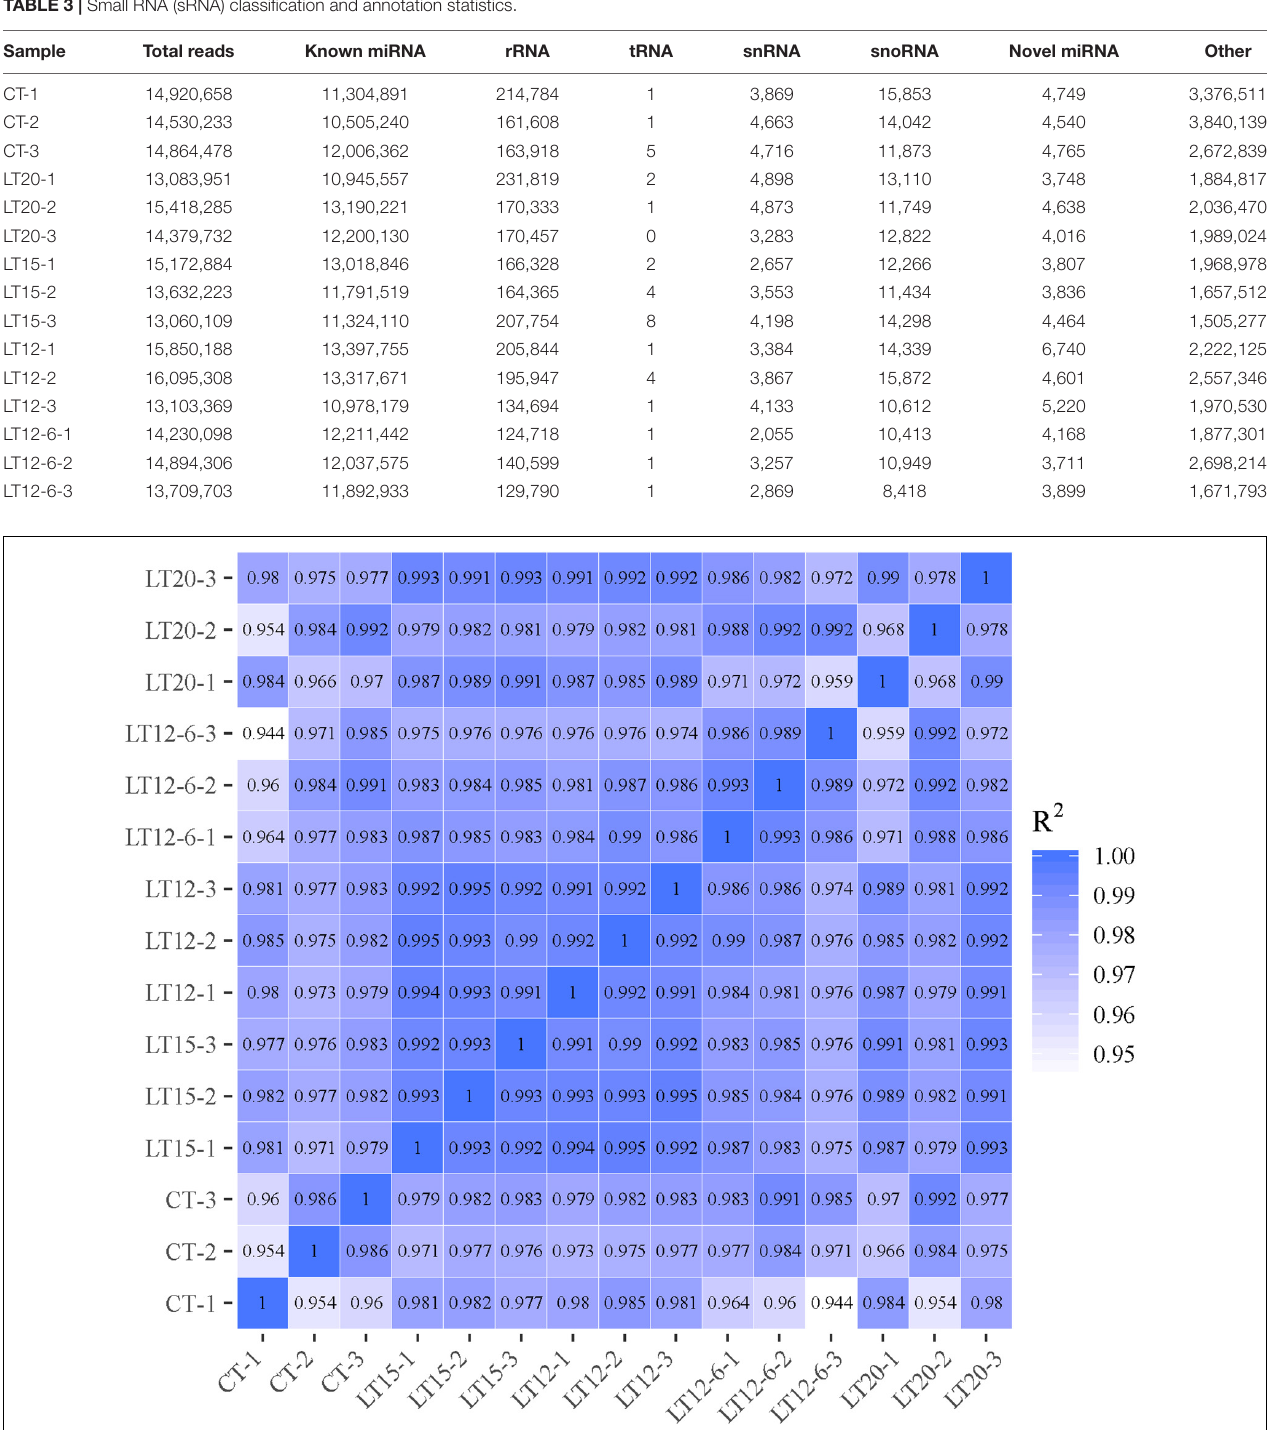
TABLE 3 | Small RNA (sRNA) classification and annotation statistics.